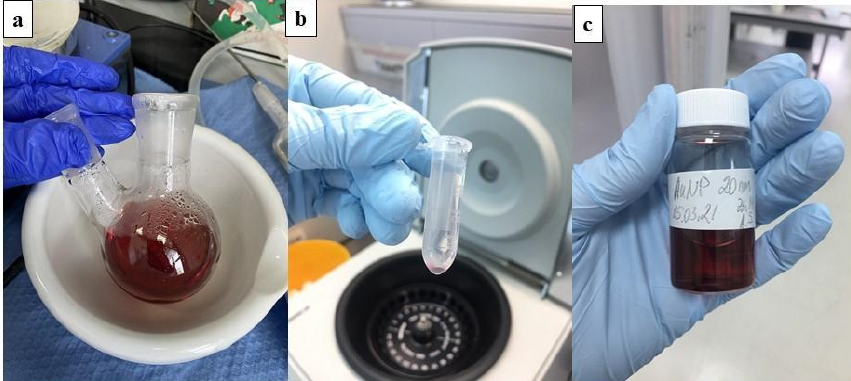
Figure 4. Gold nanoparticle cooling process ( a ) and after centrifuge ( b , c ).